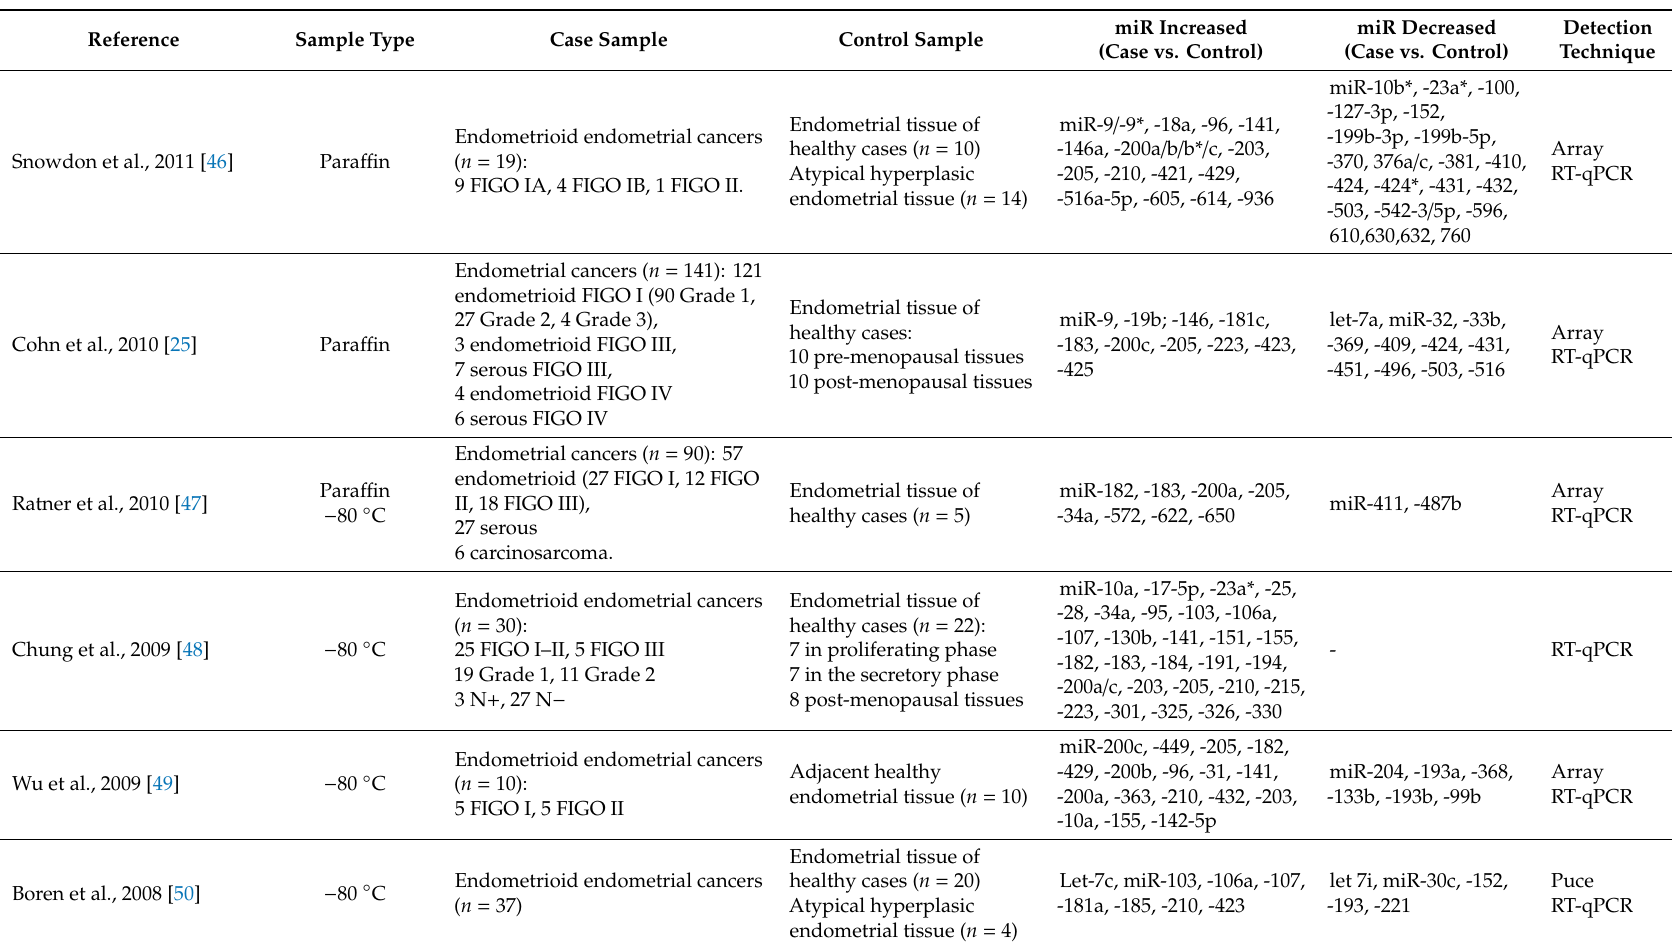
FIGO: International Federation of Gynecology and Obstetrics, N: ganglionic status, RT-qPCR: real-time quantitative polymerase chain